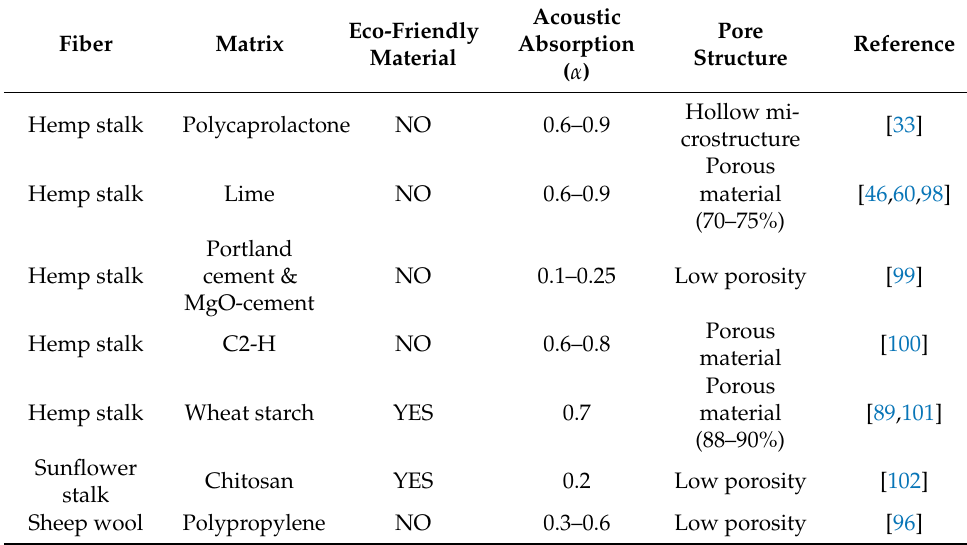
Table 4. Results of acoustic absorption of vegetal particles with different binders.